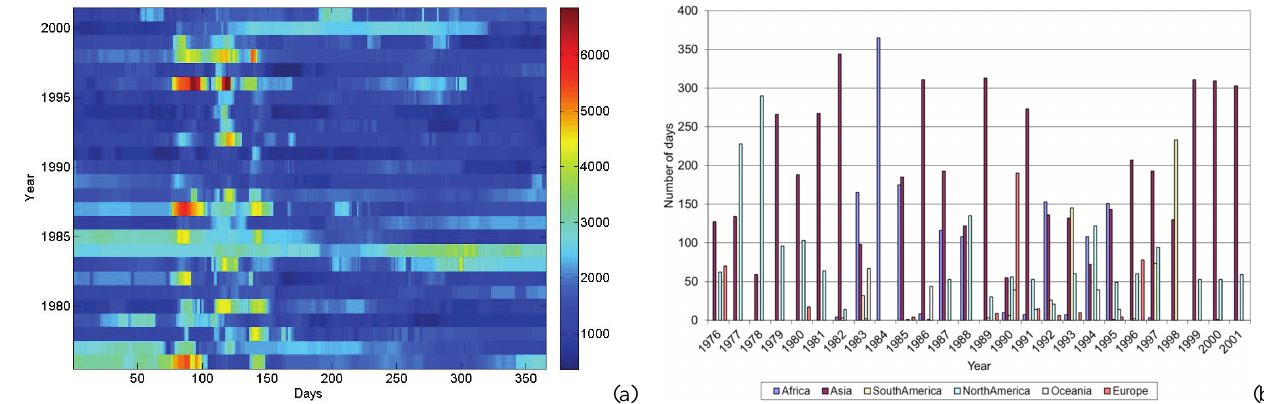
Fig. 11. Occurrence and duration of the maximum spatial drought events for the period 1976–2000. (a) Maximum area of the spatial drought event (in cells) and (b) location of the maximum spatial drought event and number of